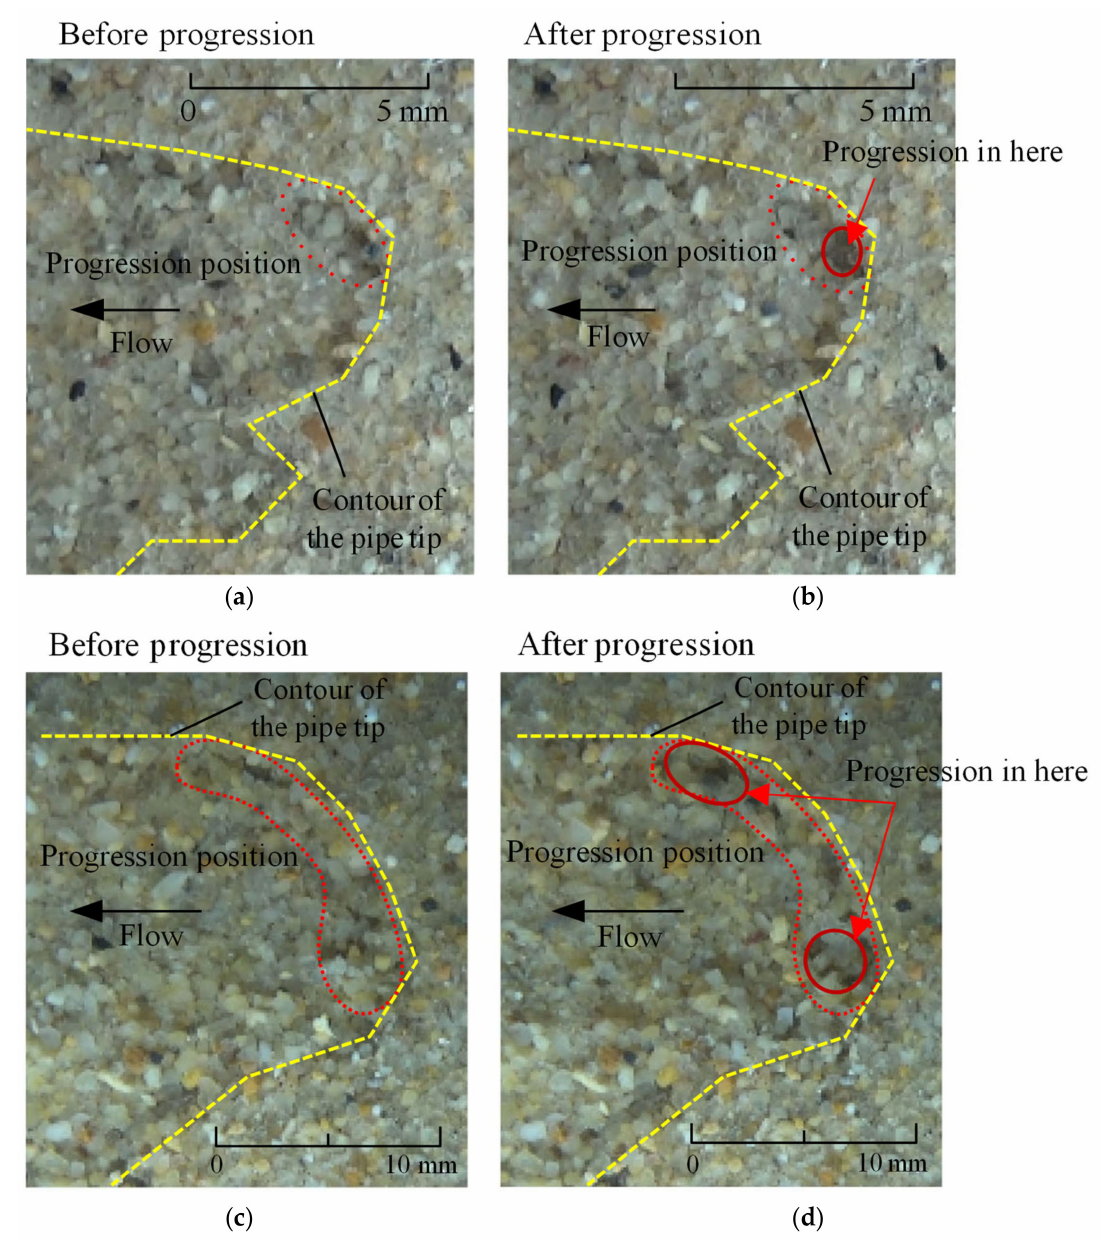
Figure 8. Examples of the plane of the equilibrium pipe tip and deeper area at the toe of the scarp of the pipe tip in two experiments: ( a ) test 1 before progression; ( b ) test 1 after progression; ( c ) test 2 before progression; ( d ) test 2 after progression (Images by Xiao